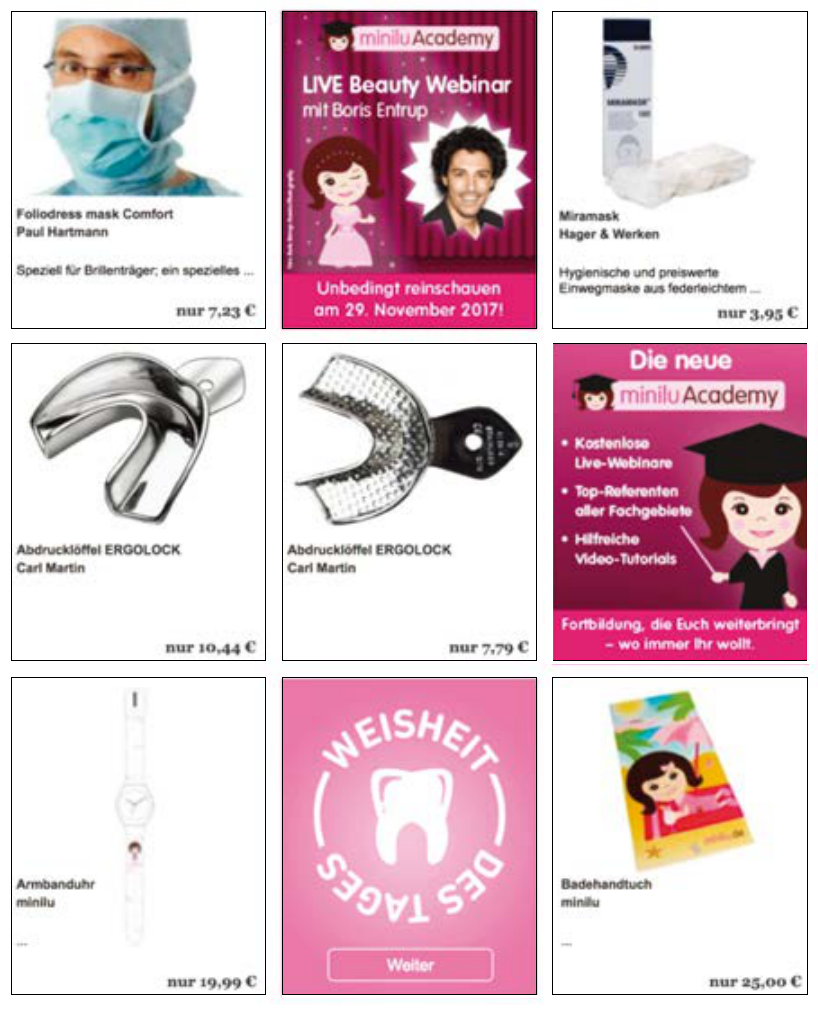
Figure 8: The associated web shop combines technical products with references to beauty webinars and online